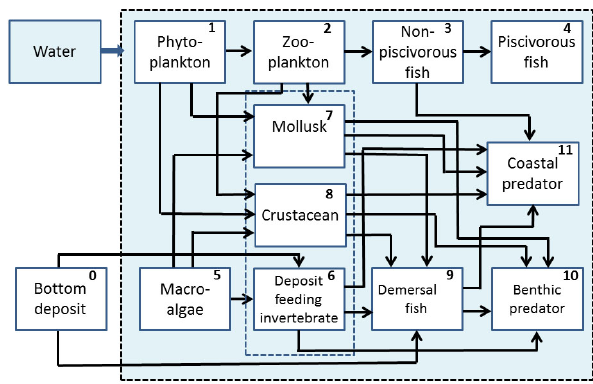
Figure 1. Biological compartments with corresponding numbers (reported in the text and tables) and radionuclide transfer (ar- rows) for extended dynamic food chain BURN model. Compart- ments within the shadowed rectangle also exchange radionuclides directly with the surrounding water. The output from the compart- ment POSEIDON-R model is shown by the external boxes, namely water and bottom